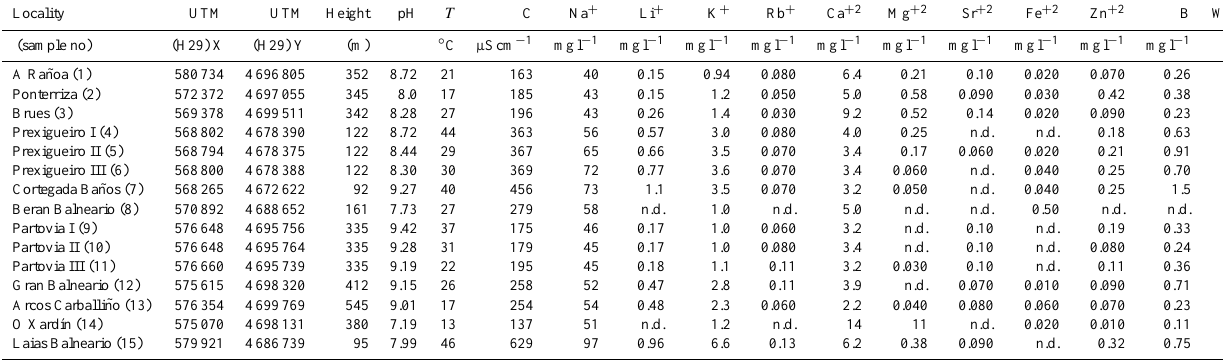
Table 1. Sampling sites, and in-site (pH, T and C) and laboratory measurements of the 15 thermal water samples. Locality